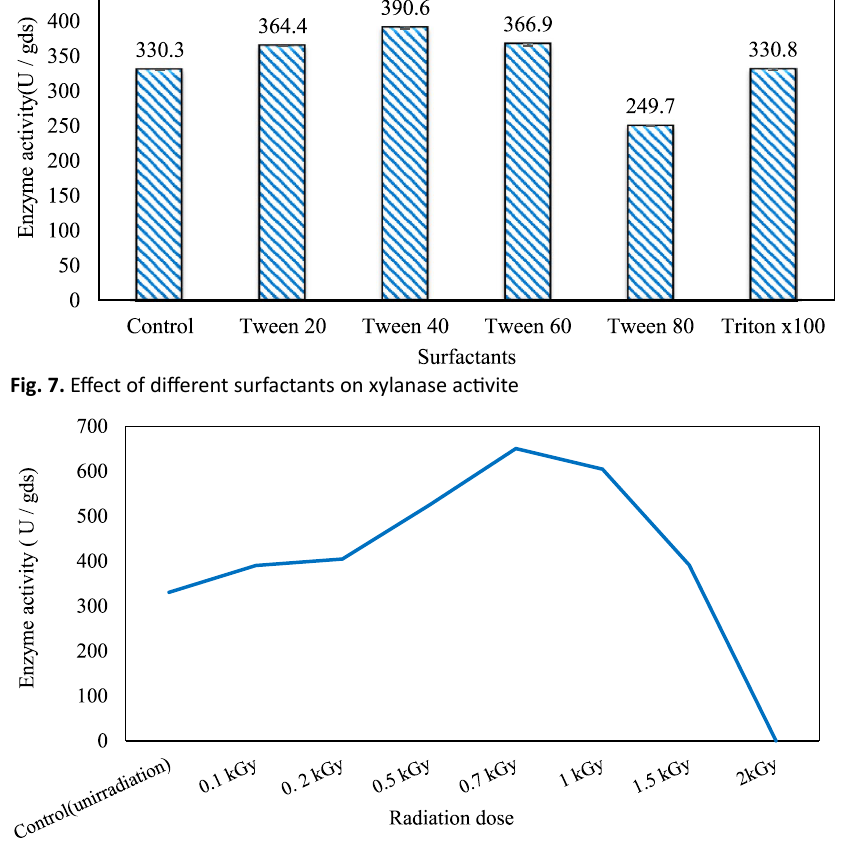
Fig. 8. Effect of different gamma-irradition doses on xylanase activity